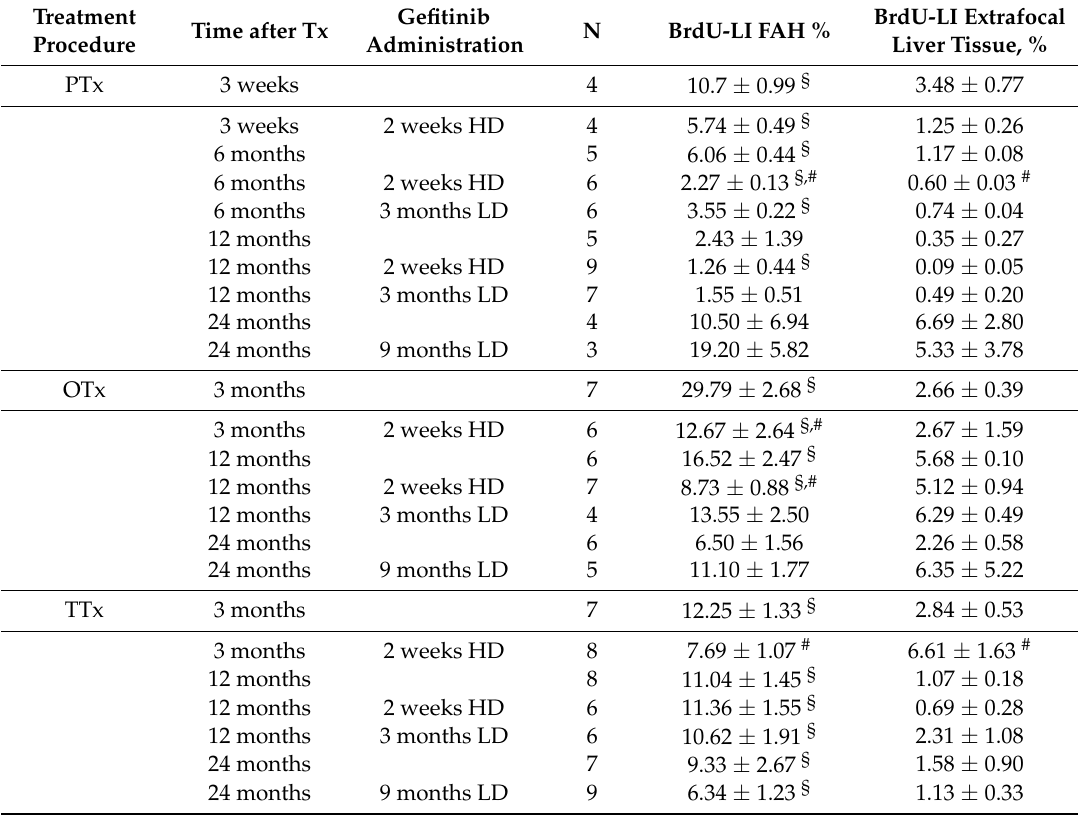
Table 2. The effect of gefitinib treatment on the proliferative activity of pre-neoplastic liver lesions and extrafocal liver tissue in hormonal